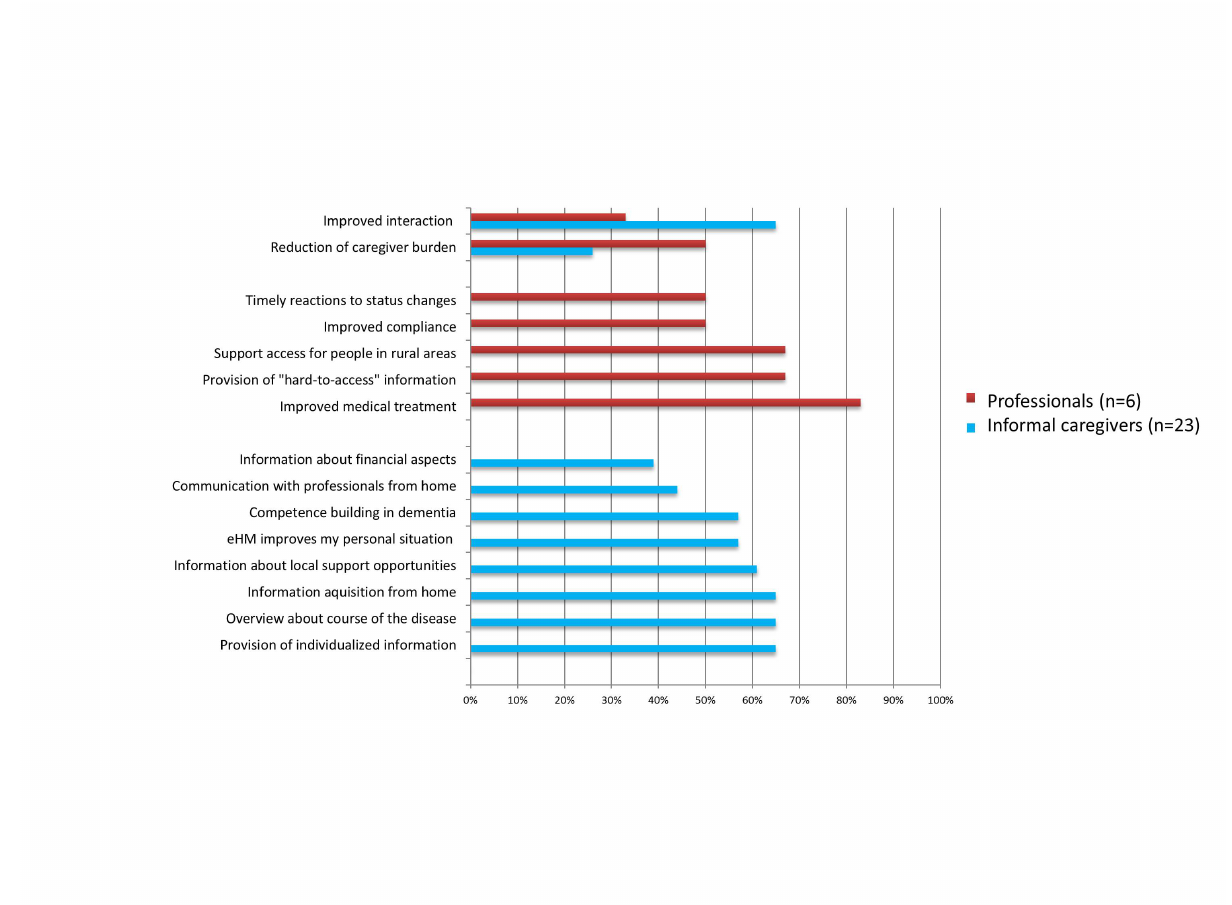
Figure 6. Perceived usefulness of the